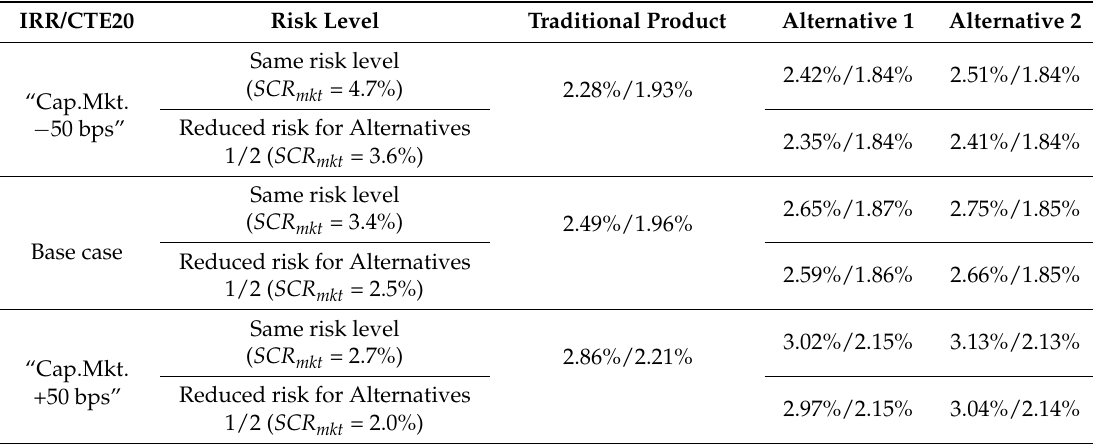
Table 6. IRR and CTE20 for products with the same SCR mkt , and with reduced SCR mkt for alternative products, for base case and capital market sensitivities ( ˘ 50